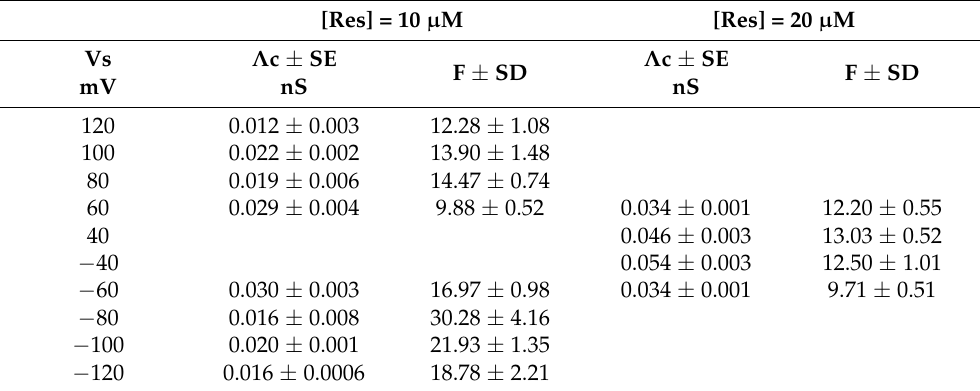
Figure 4. Resveratrol channel-like activity in POPC planar lipid membranes (PLMs). Representative traces illustrating channel activity of resveratrol in membranes made up of POPC with associated histograms of the conductance fluctuations. The histograms of the probability, P( Λ ), for the frequency of a given conductivity unit were fitted by a Gaussian which is shown as a solid curve. Experiments were performed in the presence of 10 µ M (top trace) and 20 µ M (bottom trace) of resveratrol added to the cis side, while the aqueous phase contained 0.1 M KCl (pH 7) and T = 23 ± 1 ◦ C. Applied voltage was set to 60 mV (top trace) and 40 mV (bottom trace). Table 1. Characteristic parameters of resveratrol channel-like event in POPC PLM. The mean conductance ( Λ c ± SE) and frequency (F ± SD) of resveratrol channel-like events at different applied voltages. The minimum and maximum number of channel-like events considered (N) out of a total number of channel-like events considered (Nt) was: 130 < N < 375, Nt = 1640, at the resveratrol concentration of 10 µ M. The minimum and maximum number of channel-like events considered (N) out of a total number of channel-like events considered (Nt) was: 280 < N < 622, Nt = 1757, at the resveratrol concentration of 20 µ